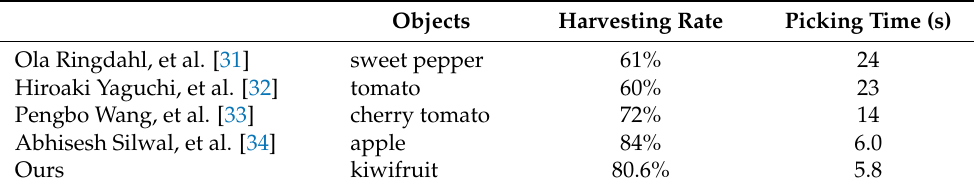
Table 3. Comparison of different fruit harvesting